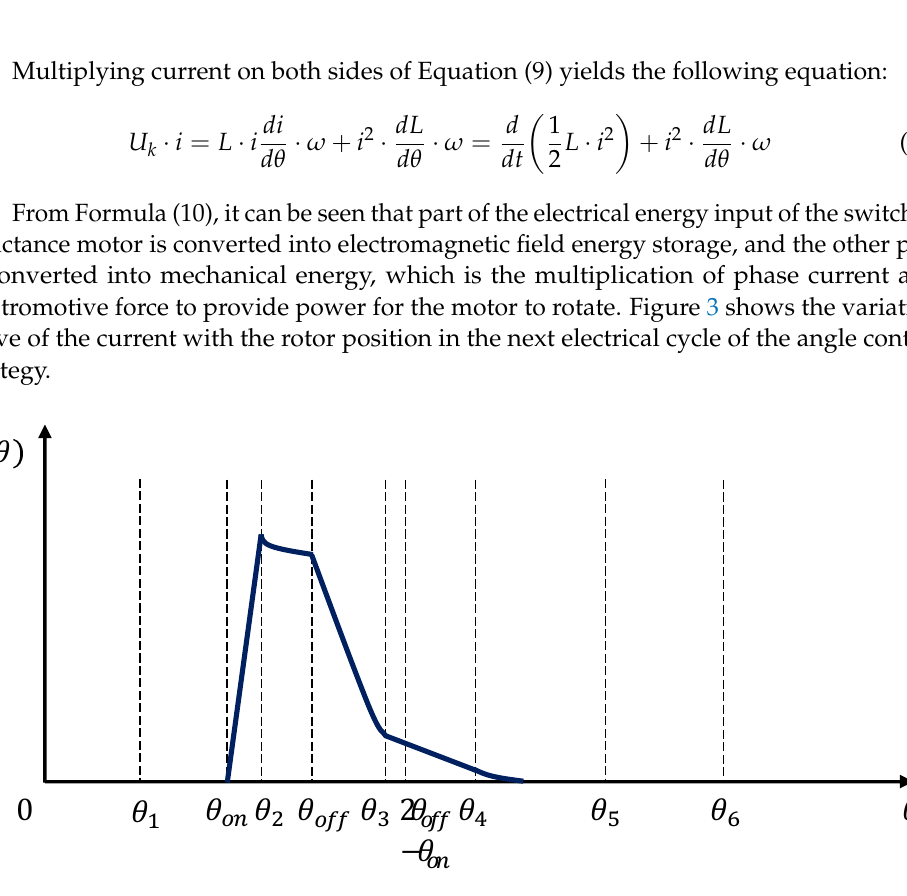
Figure 3. Current curve of one electric period.